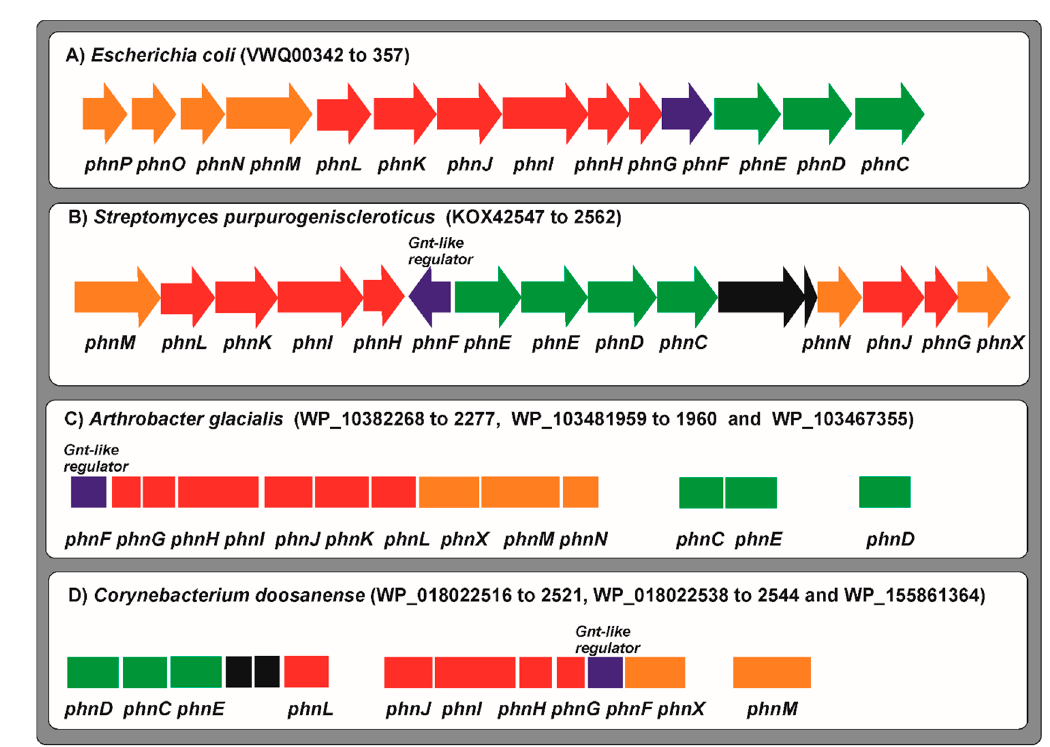
Figure 4. Clusters of genes for phosphonates transport and degradation in E. coli and Actinobacteria. The genes for uptake of phosphonates are shown in green; genes for the structural subunits of the C–P lyase are indicated in red. Genes involved in further metabolism of phosphonates are shown in orange, the phnX gene is annotated as a not specified phosphonates metabolism gene. The regulatory genes are highlighted in dark blue. Genes not related to phosphonates uptake or metabolism are shown in black. The cluster of genes of E. coli ( A ), Streptomyces purpurogeniscleroticus ( B ), Arthrobacter glacialis ( C ) and Corynebacterium doosanense ( D ) are indicated with their accession number in the Databases. The name of the genes is indicated below.